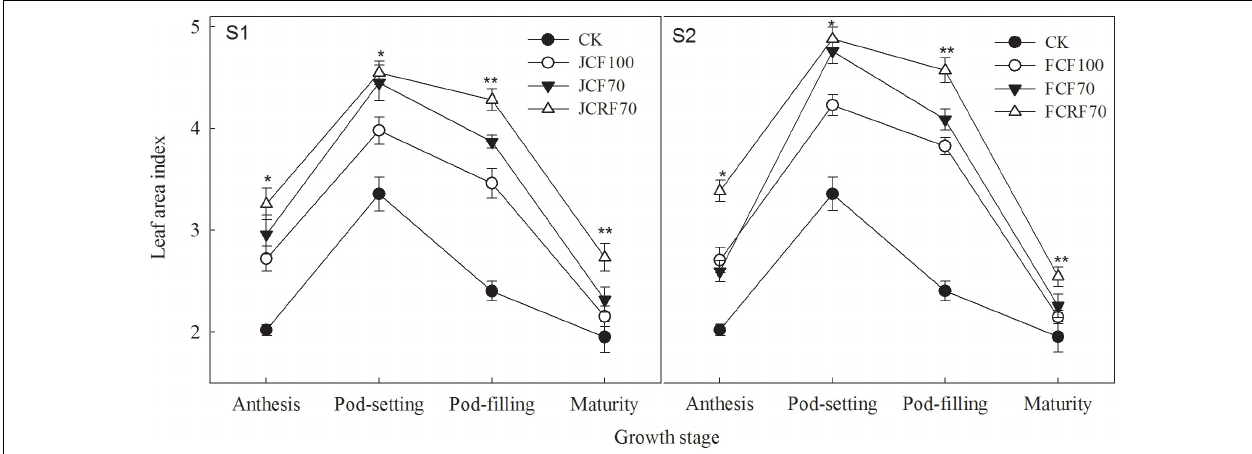
FIGURE 2 | Effect of different N fertilizer management regimes on the leaf area index (LAI) of peanut. S1, N applied at the jointing stage; S2, N withheld until the flag leaf stage. CK, control; the other symbols represent different fertilizing regimes (see text for further explanation). Means and standard errors based on three replicates are shown. NS, not significant; ∗ significant at the 0.05 probability level; ∗∗ significant at the 0.01 probability